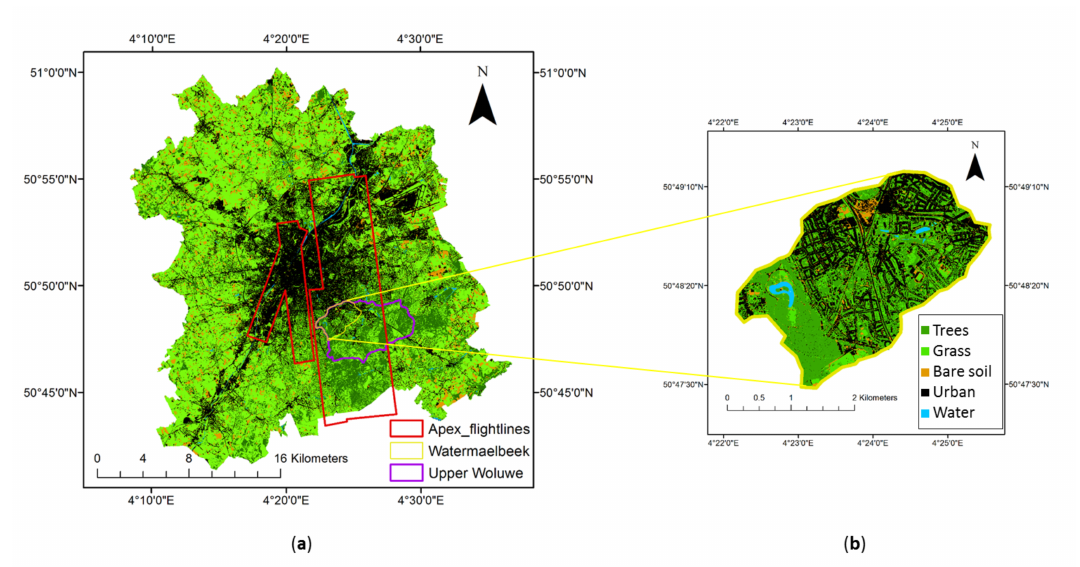
Figure 1. The Brussels region ( a ) with the study site (yellow), the APEX flight lines (red) and the upper Woluwe catchment (purple). The land cover of the WMB catchment is illustrated in the right panel ( b ). The urban fraction covers 39%, trees cover 36%, grass 17.3%, bare soil 6.5% and water 1.2% of the WMB catchment.